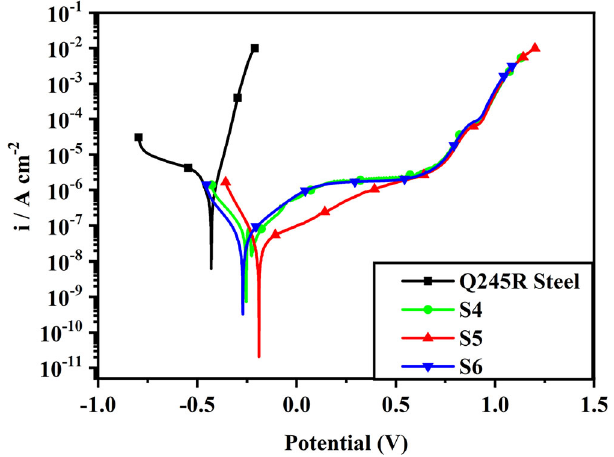
Fig. 8 The polarization curve of Q245R steel substrate (black) and Inconel 625 coatings on Q245R steel: S4 (green), S5 (red), S6